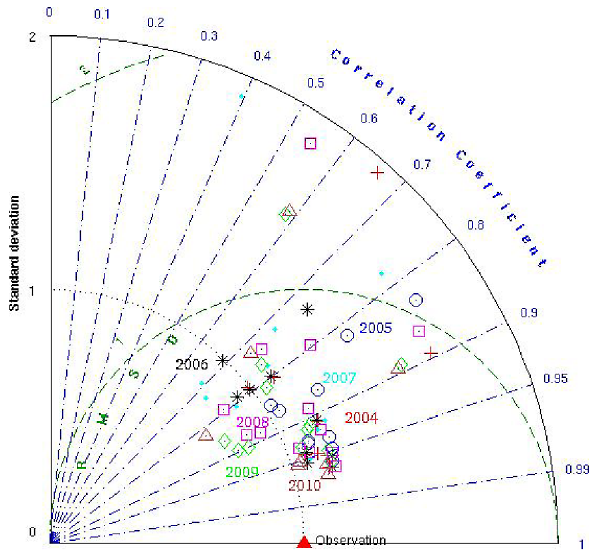
Fig. 4. Taylor diagram for model simulated and observed sea-level anomaly at 13 tidal stations from 2004 to 2010. Radial distance represents the ratio of simulated to observed standard deviations, and azimuthal angle represents model–data correlation. Green arcs represent centered root mean square difference between model and data.